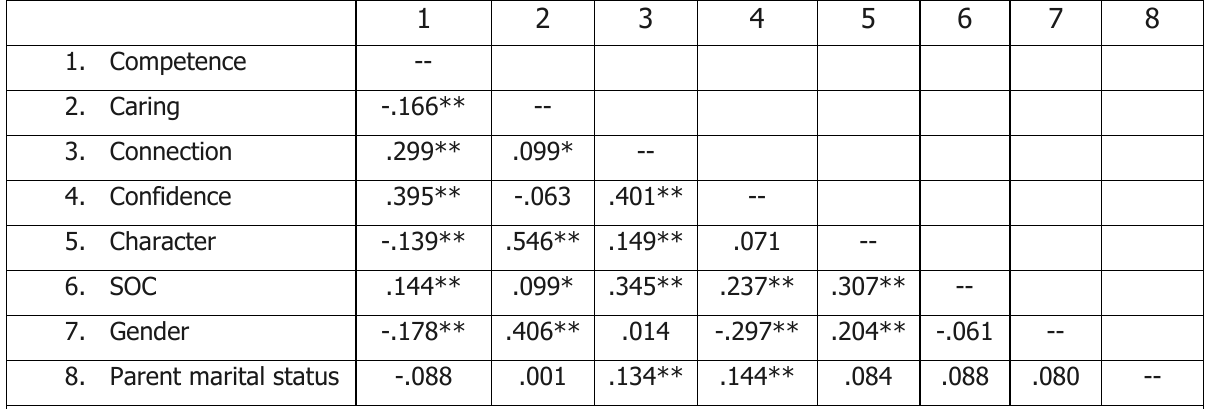
Correlations among scores for the Five Cs of PYD, SOC, and pupil demographic